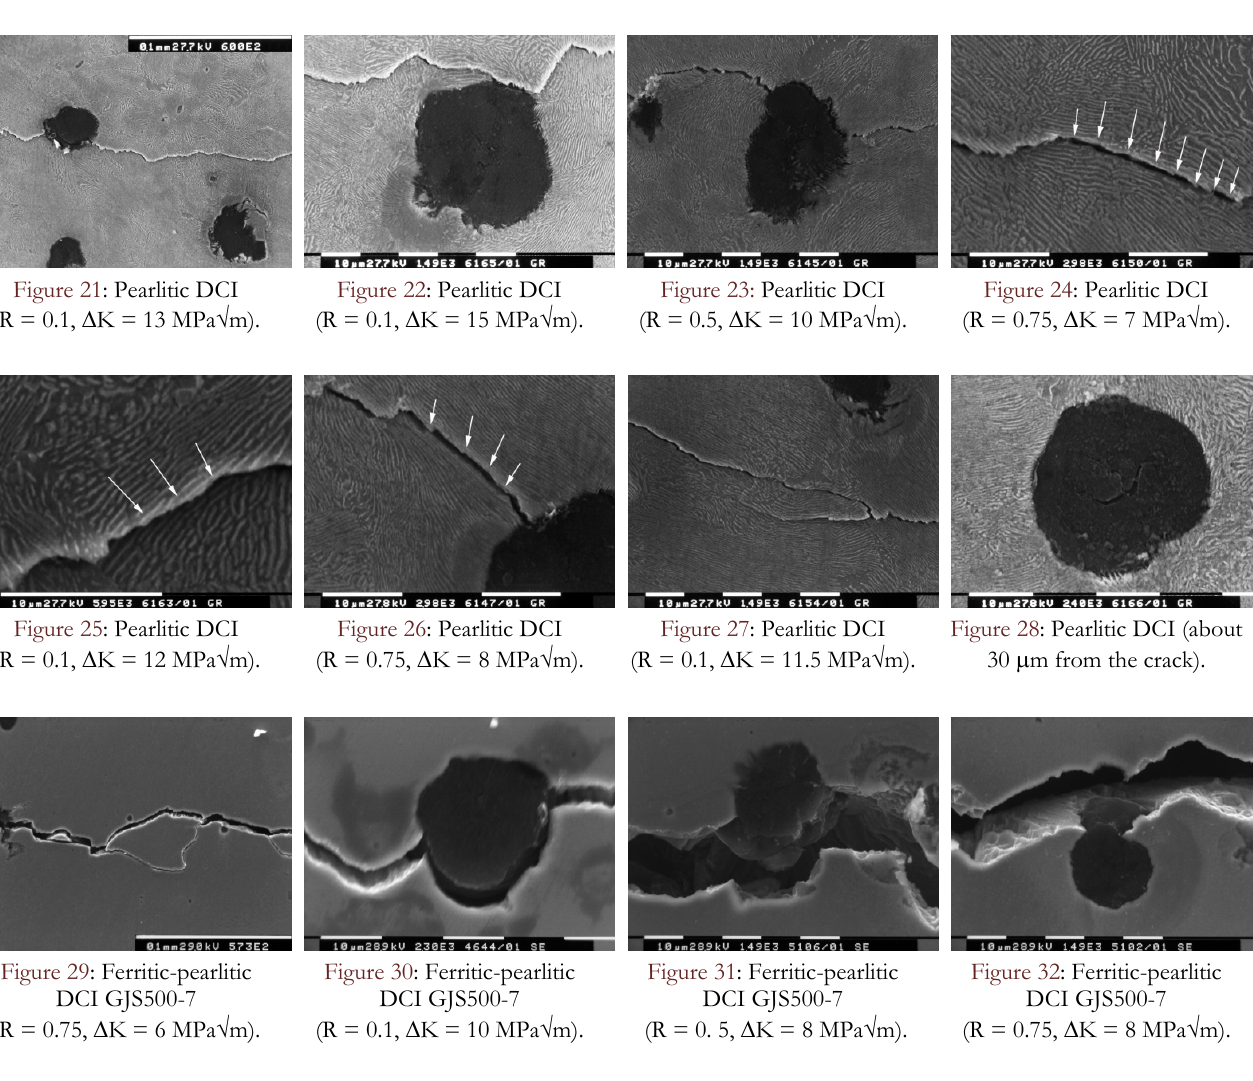
Figure 19: Ferritic DCI (R = 0.5,  K = 13 MPa √ m).